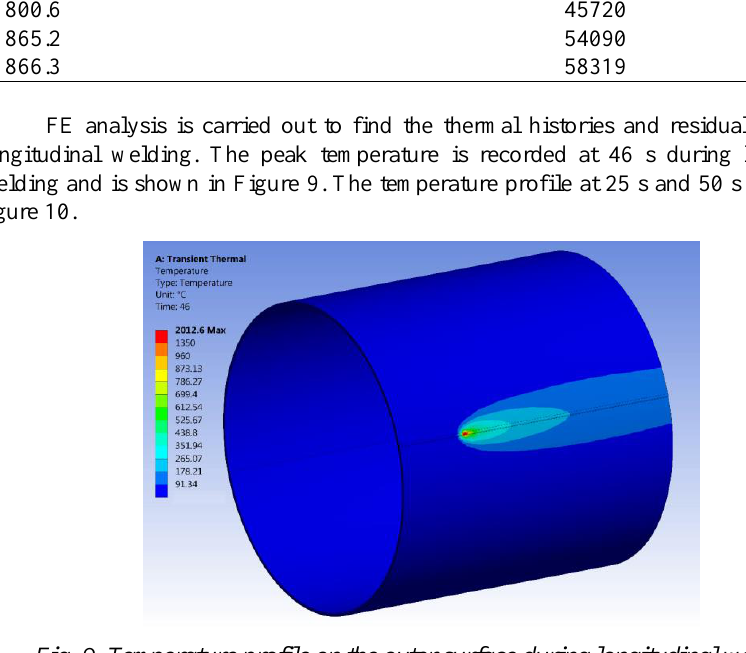
Fig. 9. Temperature profile on the outer surface during longitudinal